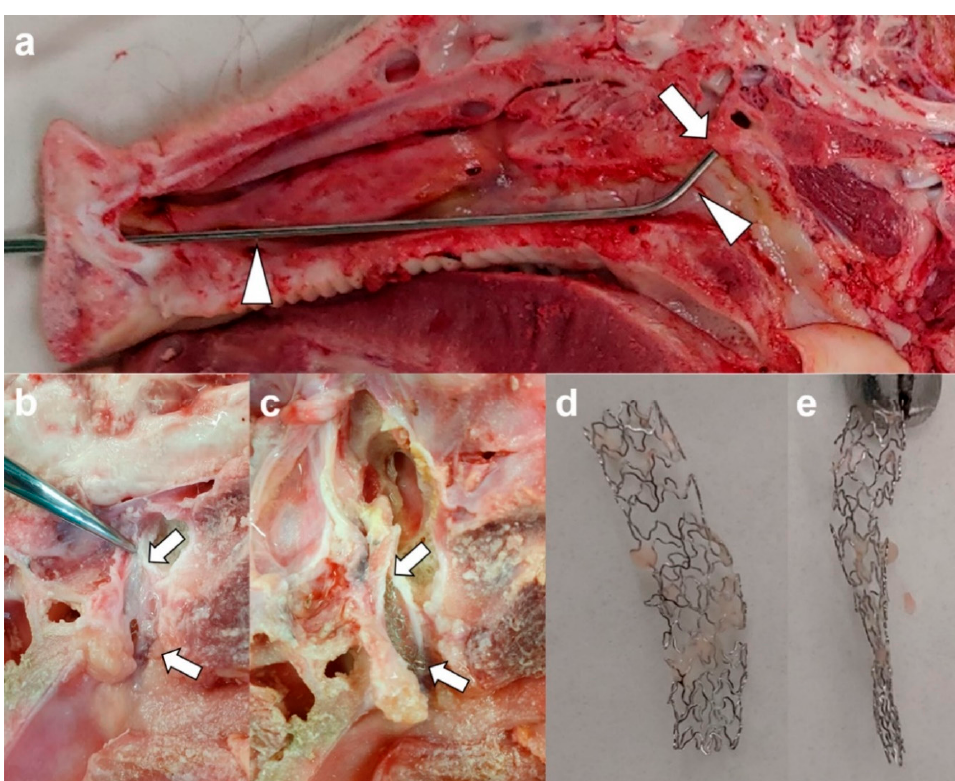
Figure 4. ( a ) Photograph showing a mid-sagittal sectioned cadaveric porcine head with the metallic guiding sheath (arrowheads) facing the orifice of the ET (arrow). ( b , c ) The photographs show the placed stent (arrows) in the ET and the extracted stent from the ET of the ( d ) frontal and ( e ) lateral views. The stent was gradually collapsed from the proximal to the distal portion.